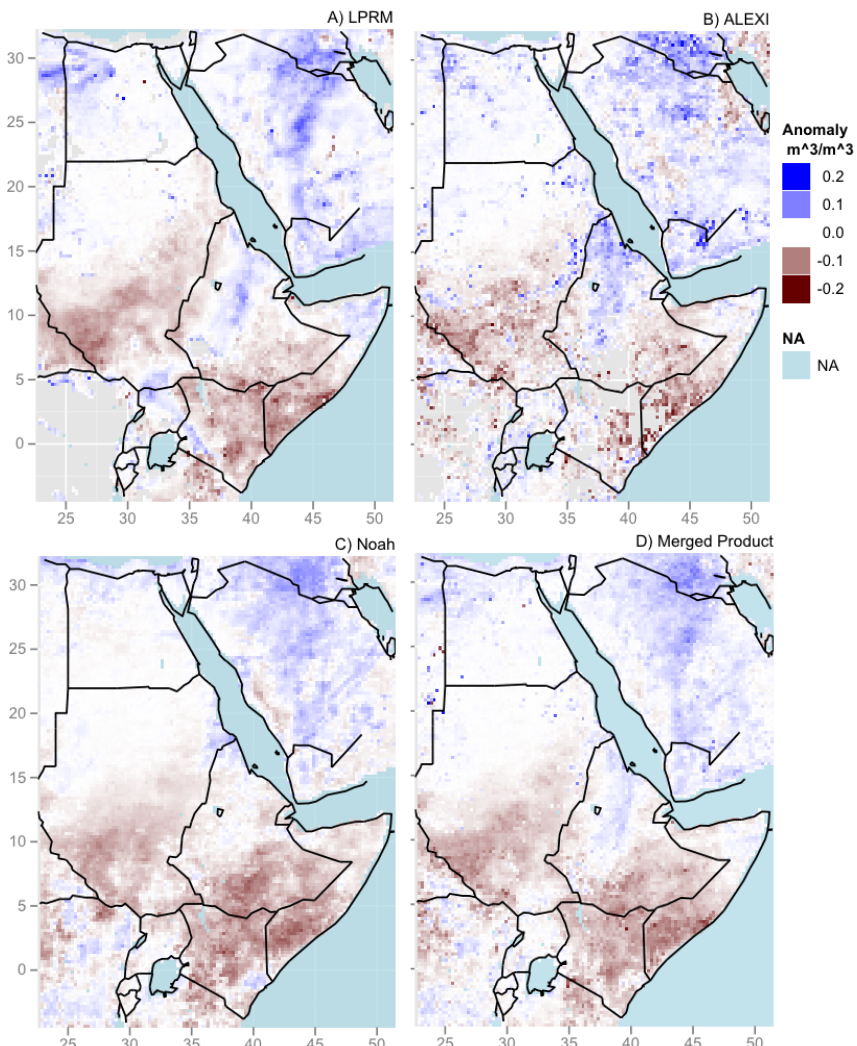
Fig. 10. Individual and merged product anomaly maps for an 8-day period during the 2011 long rainy season (28 April–6 May). (A) LPRM, (B) ALEXI, (C) Noah, (D) Merged